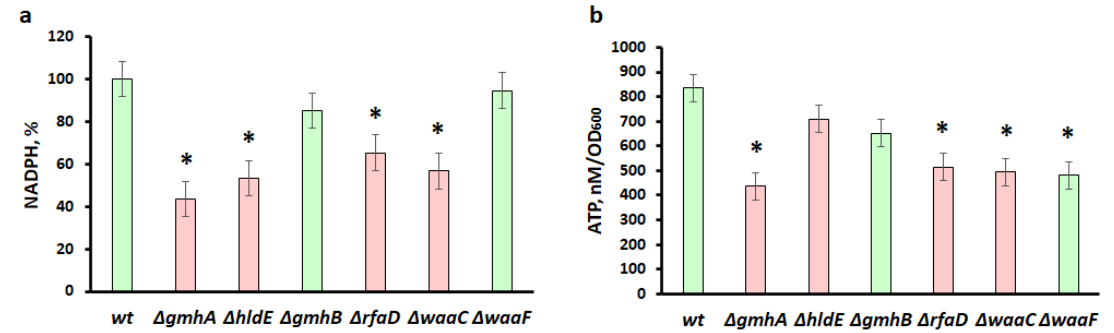
Figure 6. Changes in the intracellular content of NADPH and ATP in the population of E. coli cells with deletions of the gmhA, hldE, gmhB, rfaD, waaC, waaF genes. ( a ) Changes in the intracellular NADPH level. ( b ) Changes in the intracellular ATP level. Parameters for cells with gmhA , hldE , rfaD , and waaC deletions that result in a dramatic increase in antibiotic susceptibility in E. coli cells are shown in red, while parameters for wt , gmhB, and waaF are shown in green. Mean values ± SD from at least three independent experiments are shown. * — p < 0.05, compared to the wild-type cells.